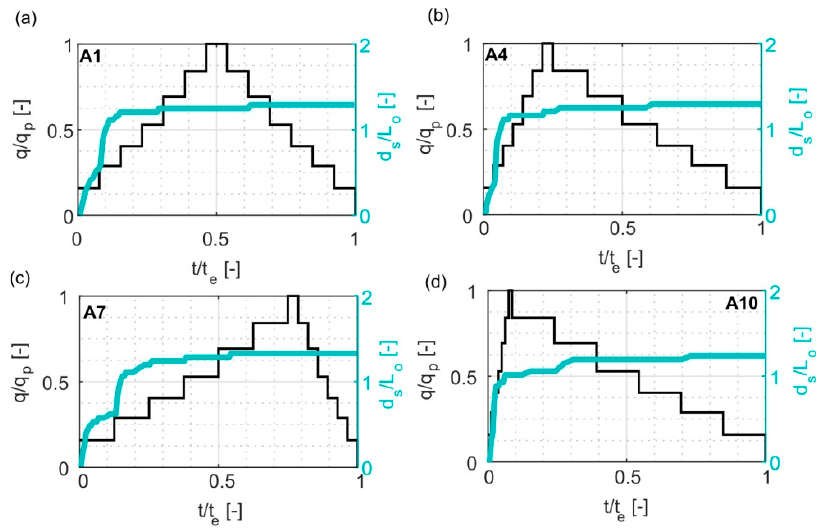
Figure 7. Evolution of normalized scour depth (d s /L o ) over nondimensional time (t/t e ) for different hydrograph shapes in Series A experiments: ( a ) symmetrical, ( b ) left-skewed, ( c ) right-skewed, ( d ) flash flood.